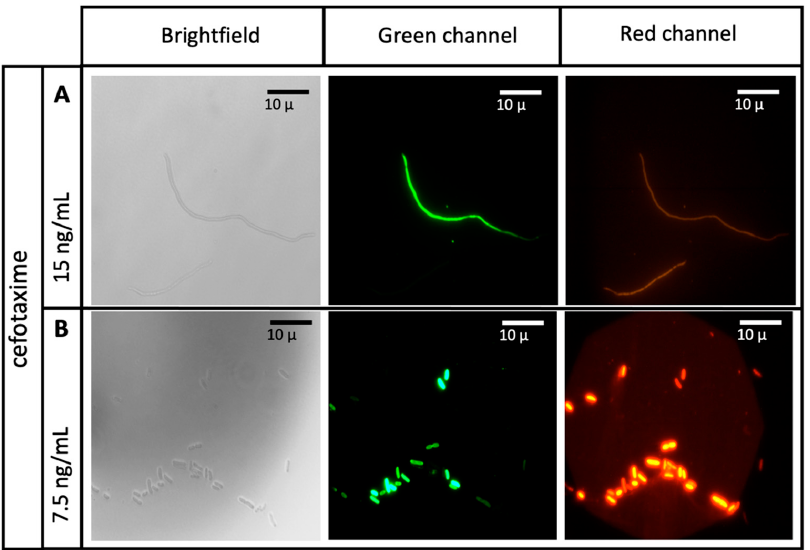
Figure 4. Epifluorescence microscopy (100x) of cefotaxime treated E. coli cells. ( A ), treatment at 15 ng/ml ( B ) treatment at 7.5 ng/ml 15 ng/mL ( B ) treatment at 7.5 ng/mL.